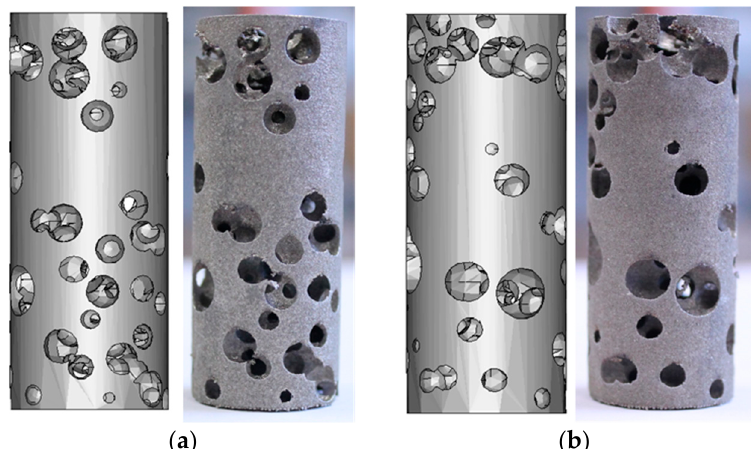
Figure 13. Comparing the nominal solid model to the built foam, ( a ) and ( b ) are views of opposite sides.